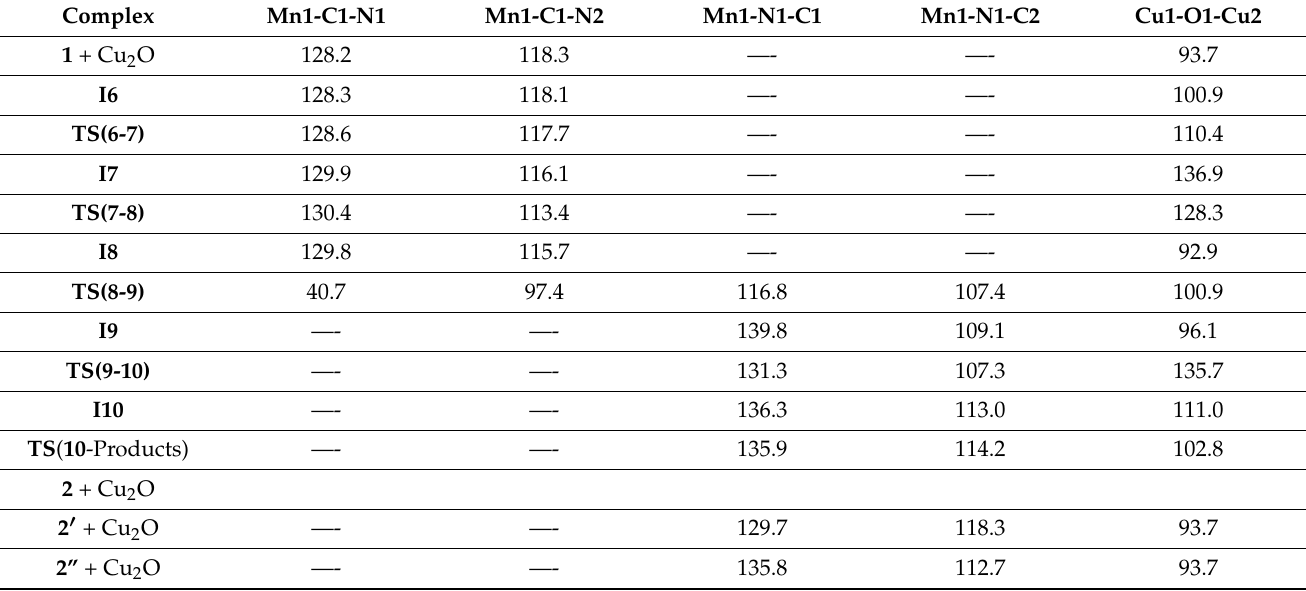
Table 4. Selected bond angles ( ◦ ) of theoretically optimized structures (B3P86/6-31+G(d) level of theory) in mechanism M2